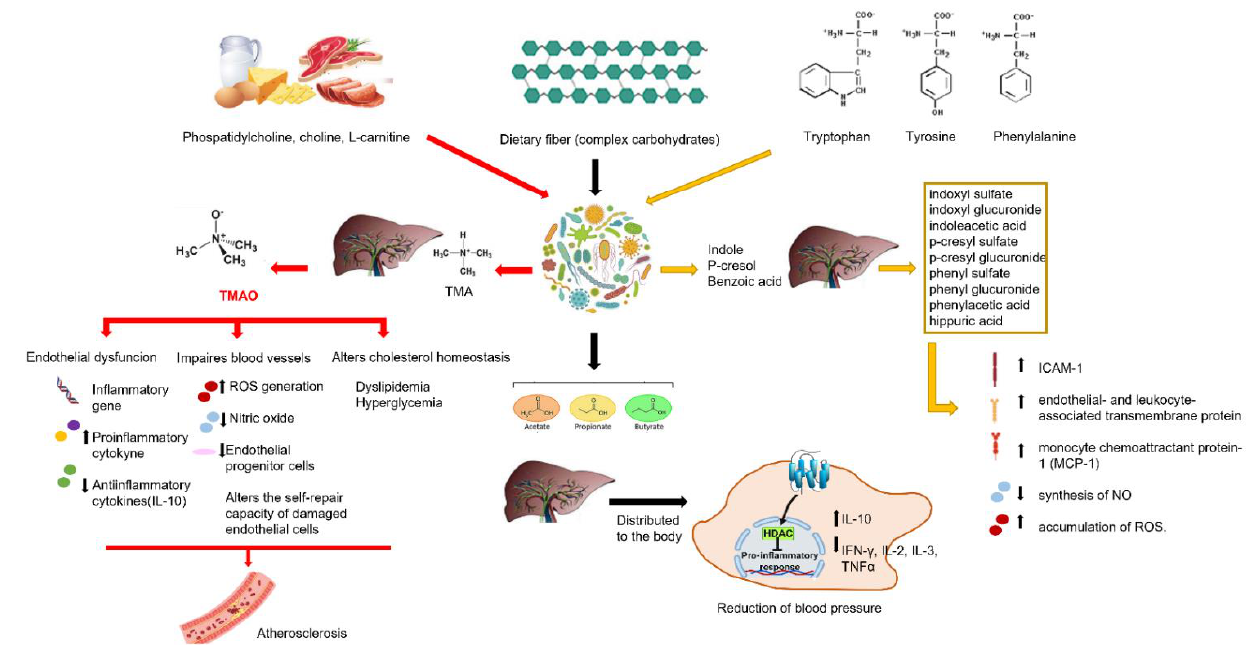
Figure 5. Effects of circulating metabolites on endothelium.